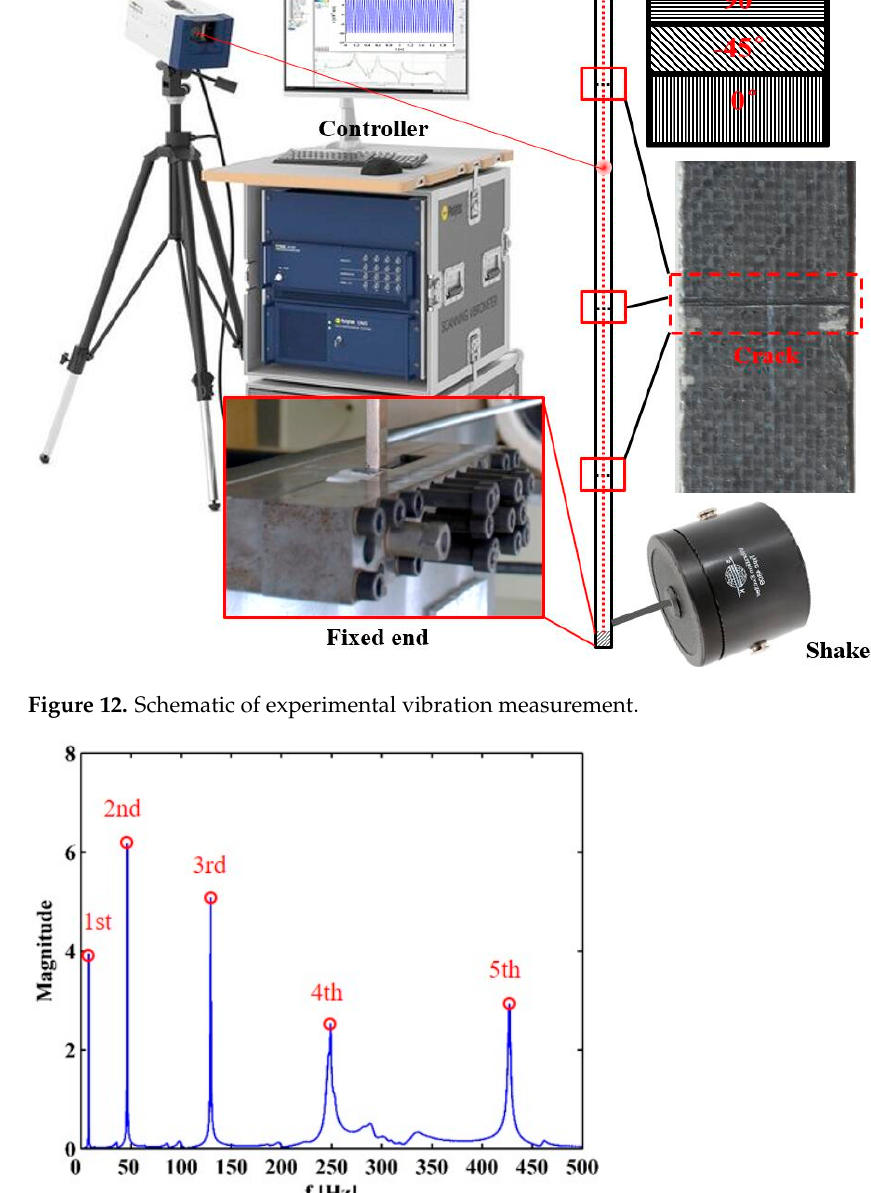
Figure 13. FRF of the CFRP laminated beam (the first five natural frequencies are marked by red dots).